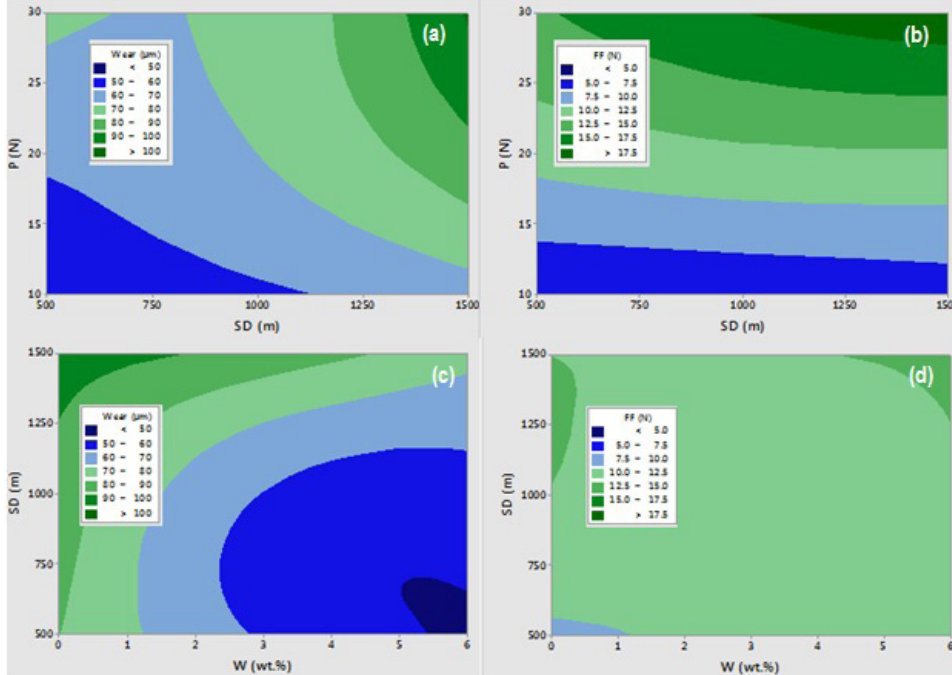
Figure 2. Correlation between (a) Load, SD and Wear (b) Load, SD and FF (c) SD, Wt % and Wear(d) SD, Wt % and